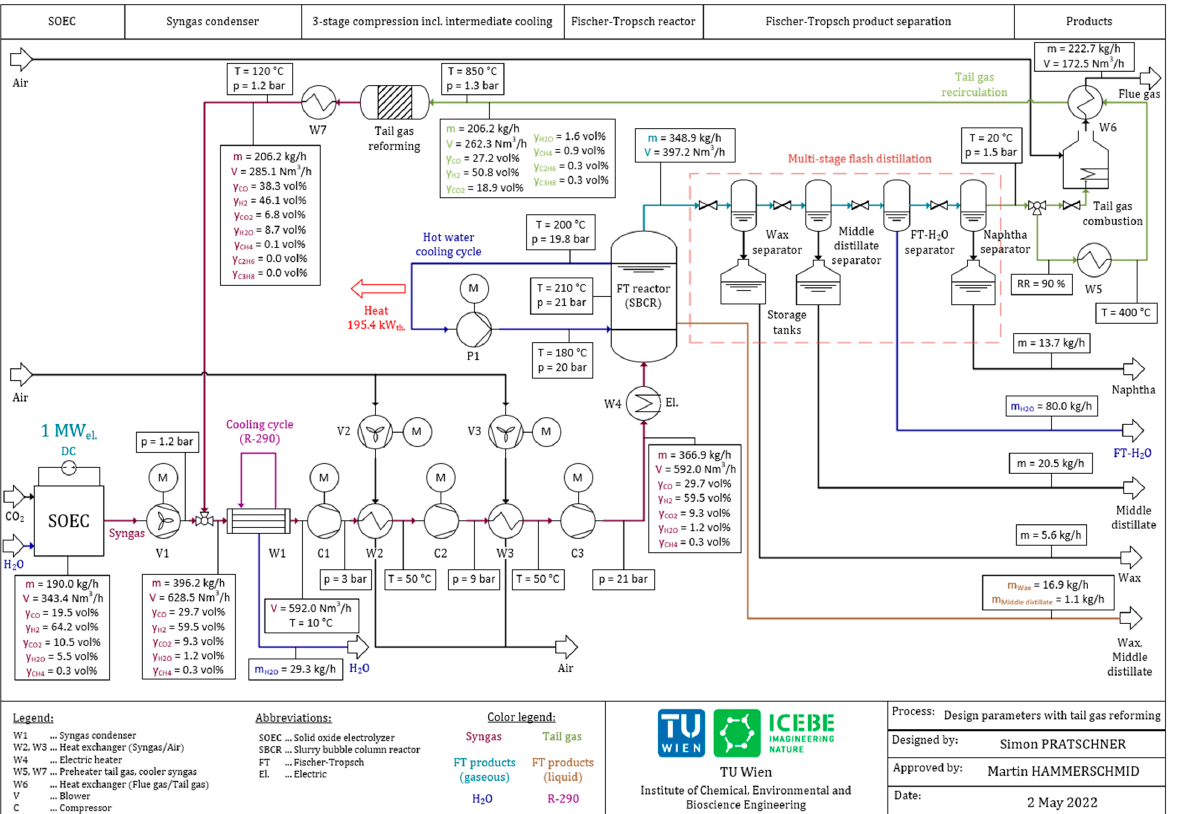
Figure 6. Design parameters of the plant configuration including tail gas reforming.